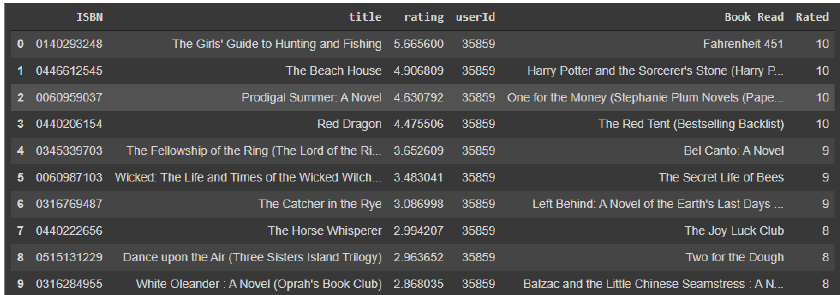
Fig. 4. List of surprise library